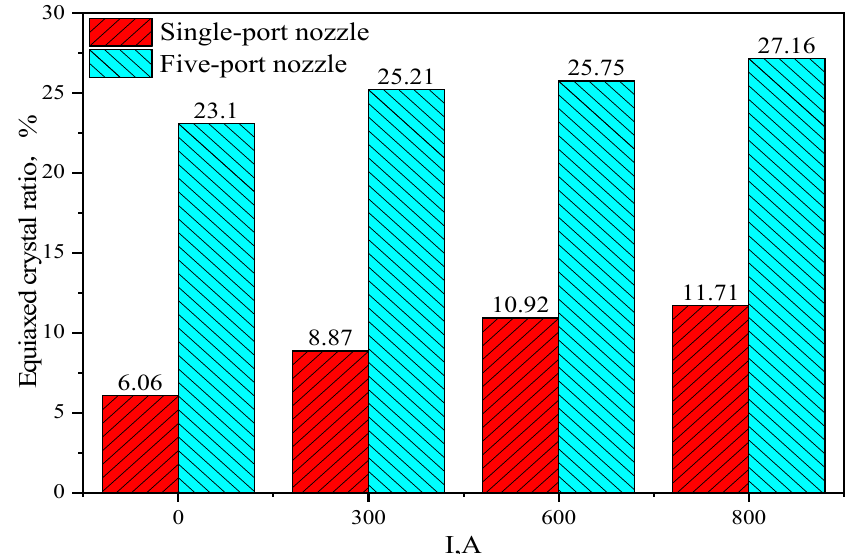
Figure 11. Comparison of equiaxed crystal ratio of bloom strands.